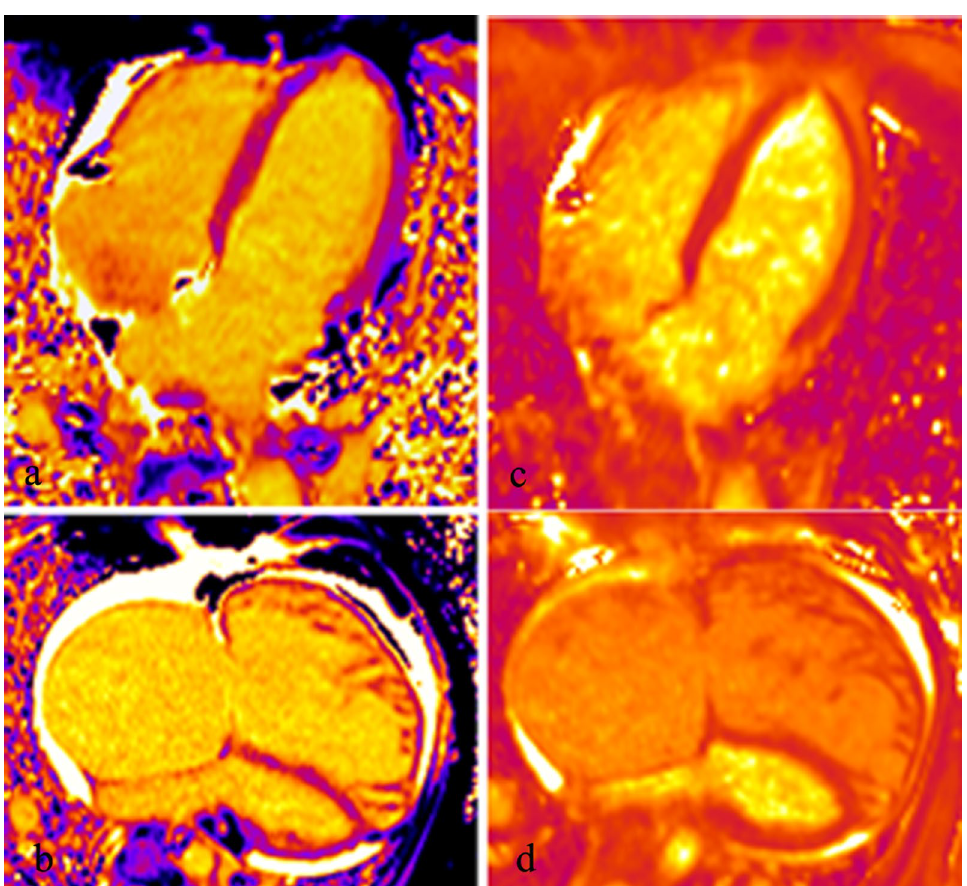
Fig. 4 The representative T1 and T2 Maps in a healthy volunteer and a patient with PH. a the long-axial four-chamber T1 Map in a 42-year male healthy volunteer. b The long-axial four-chamber T1 Map in a 42-year male patient with PH. c the long-axial four-chamber T2 Map in a 42-year male